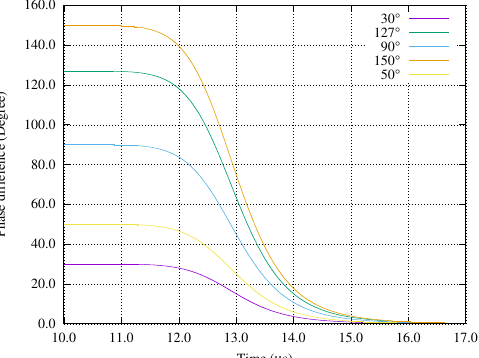
Figure 5. Oscillator phase synchronization. SPICE simulation of the oscillator in ideal phase. gm 1 = gm 2 = gm 3 = 1/ R 3 = 1 mA/V, C 1 = C 2 = 10 nF, R 1 = 1/ ( 2 π ) 2 k Ω . F sync is a sinusoidal voltage signal, with 1 MHz and 1 V pp